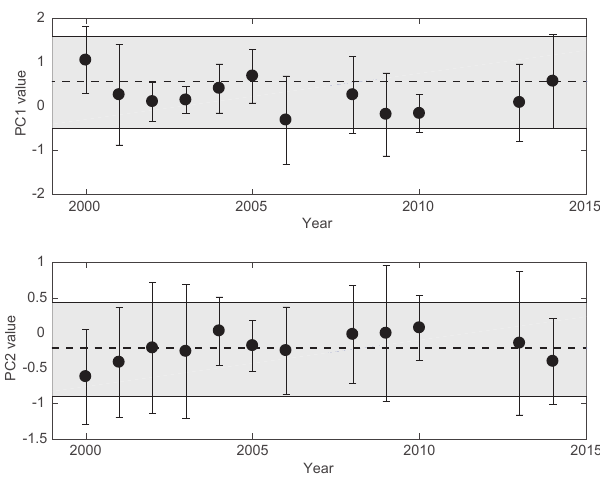
Figure 9. Interannual variability in SPOT cruise profiles versus high-resolution glider profiles. The mean and standard deviation of the PC1 and PC2 values for the SPOT cruise profiles from 2000 to 2011 are shown. The mean (dashed line) and standard deviation (grey shading) of the 2013 and 2014 glider profiles are also indi-